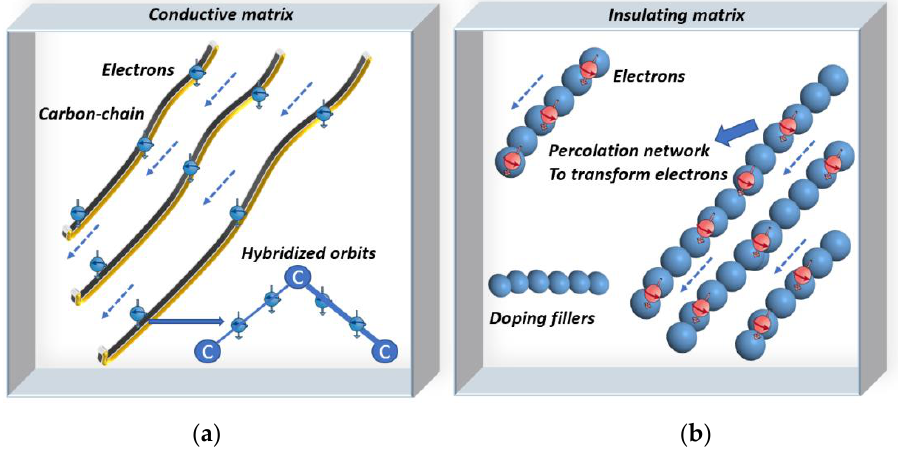
Figure 2. Conducting mechanism of intrinsic ( a ) and extrinsic ( b ) polymers. Electrons in hybridized orbits are released by bond-breaking methods such as heating and doping with fillers [27,28]. In extrinsic polymers, doping fillers form networks to transfer electrons [26].